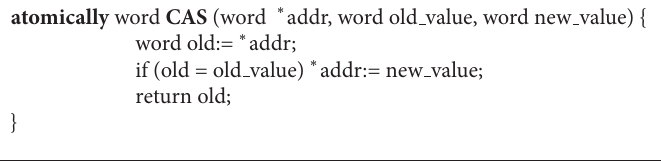
Algorithm 1: Abstract definition of CAS primitive.